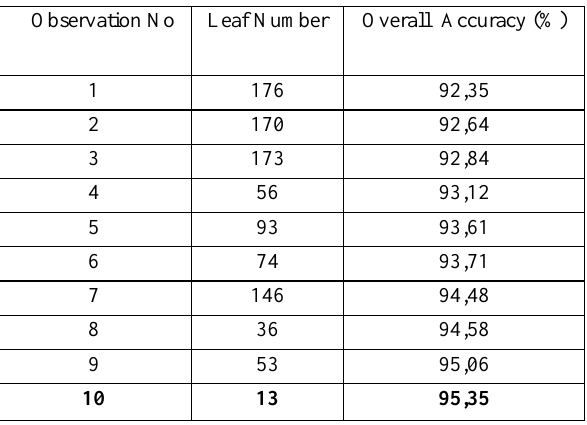
Table 1. Parameter values belonging to Classification tree